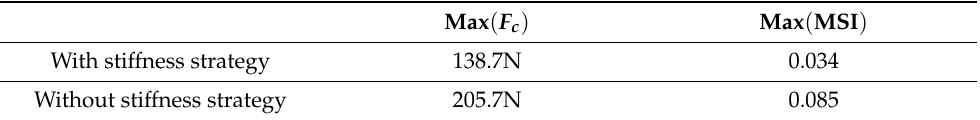
Table 3. Comparison of results with and without real-time joint stiffness configuration strategy.